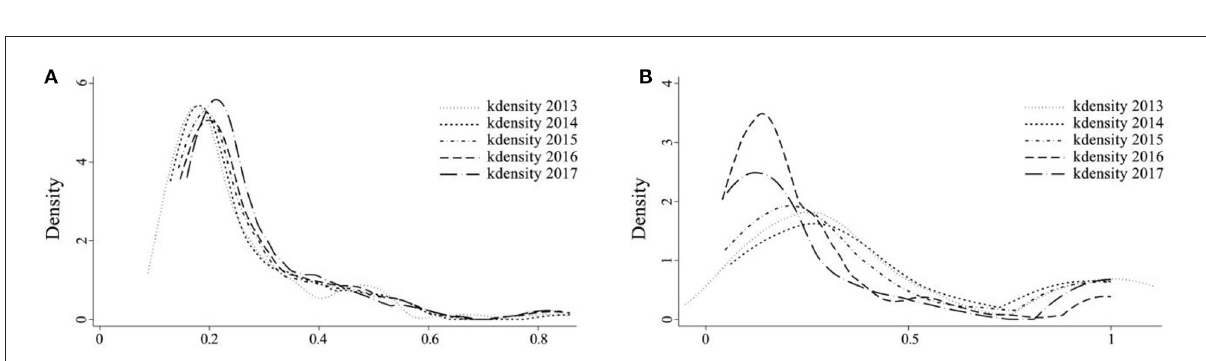
FIGURE4 Kernel density curve of urbanization level and eco-efficiency of agricultural counties and districts in Liaoning province (2013–2017). (A) Urbanization levels. (B) Eco-efficiency.